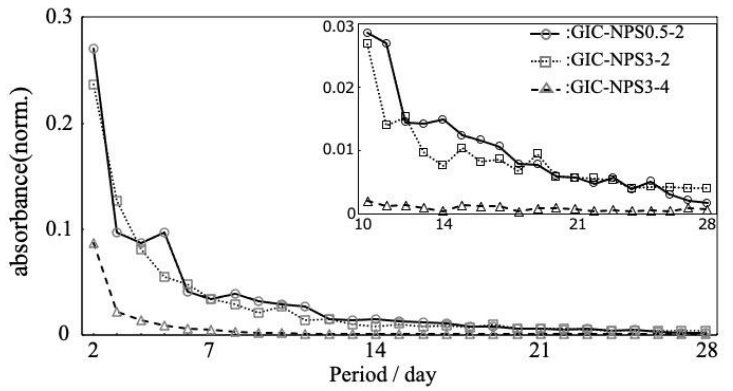
Figure 3. The time profile of the absorbance of released RhB from GIC–NPS.